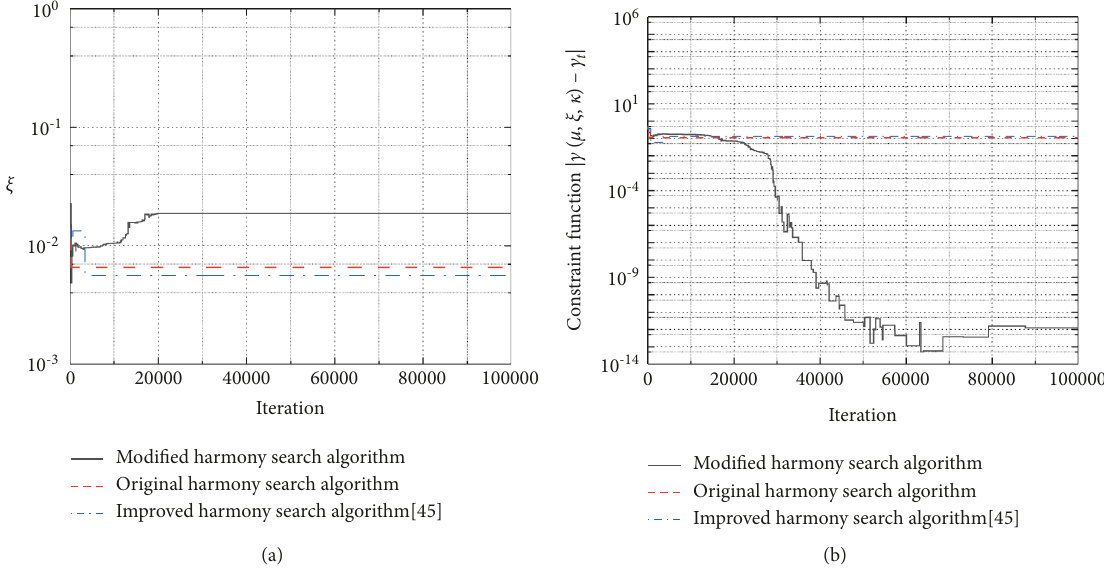
Figure 10: The variation trends of key indices during the optimization process for case 6. (a) The nominal damping ratio ξ . (b) The constraint function | c ( μ , ξ , κ ) − c t |